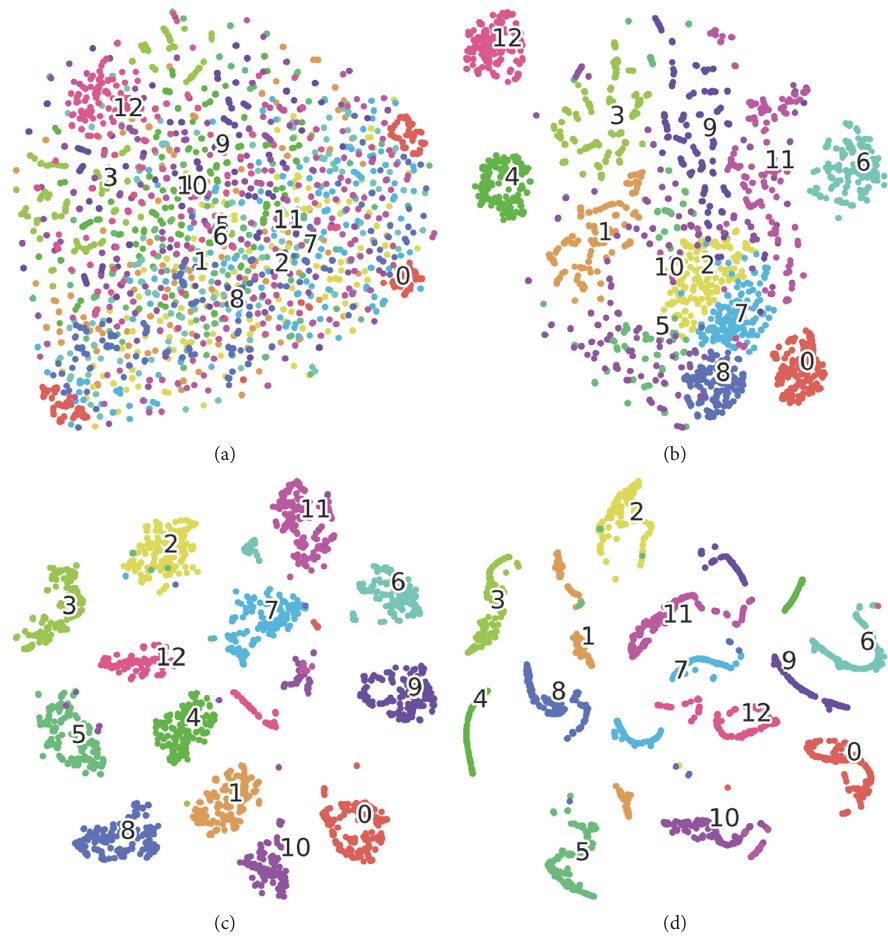
Figure 8: Layerwise visualization based on T-SNE. (a) Input layer, (b) 1st LSTM layer, (c) 2nd LSTM layer, and (d) 3rd LSTM